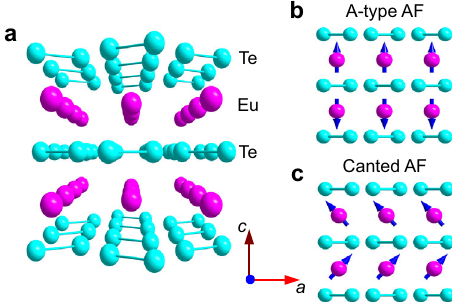
Fig. 1 Crystal and magnetic structures of EuTe 2 . a Schematic view of the layered crystal structure of EuTe 2 , b Type-A antiferromagnetic (AF), and c Canted AF structure of Eu 2 + spins in EuTe 2